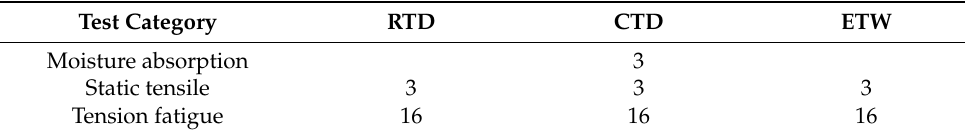
Table 1. Test types and specimen number.